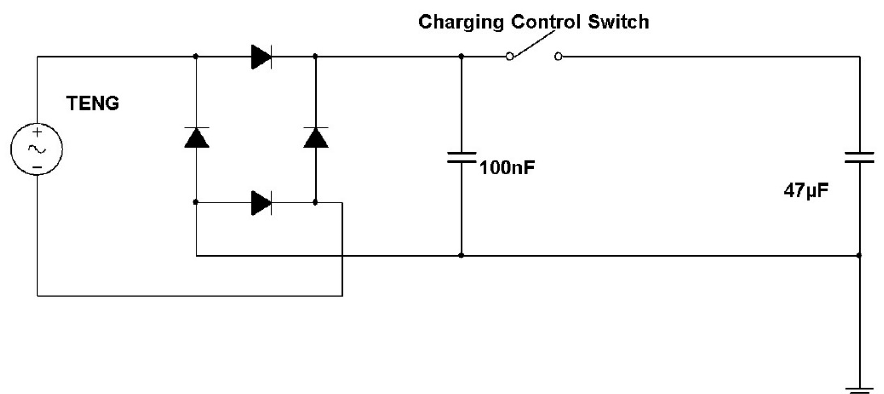
Figure 1. Circuit diagram of the full-bridge rectifier and charging circuit. The expected power supplier is the HDR-TENG device. The target charging component is the 47 μ F capacitor.